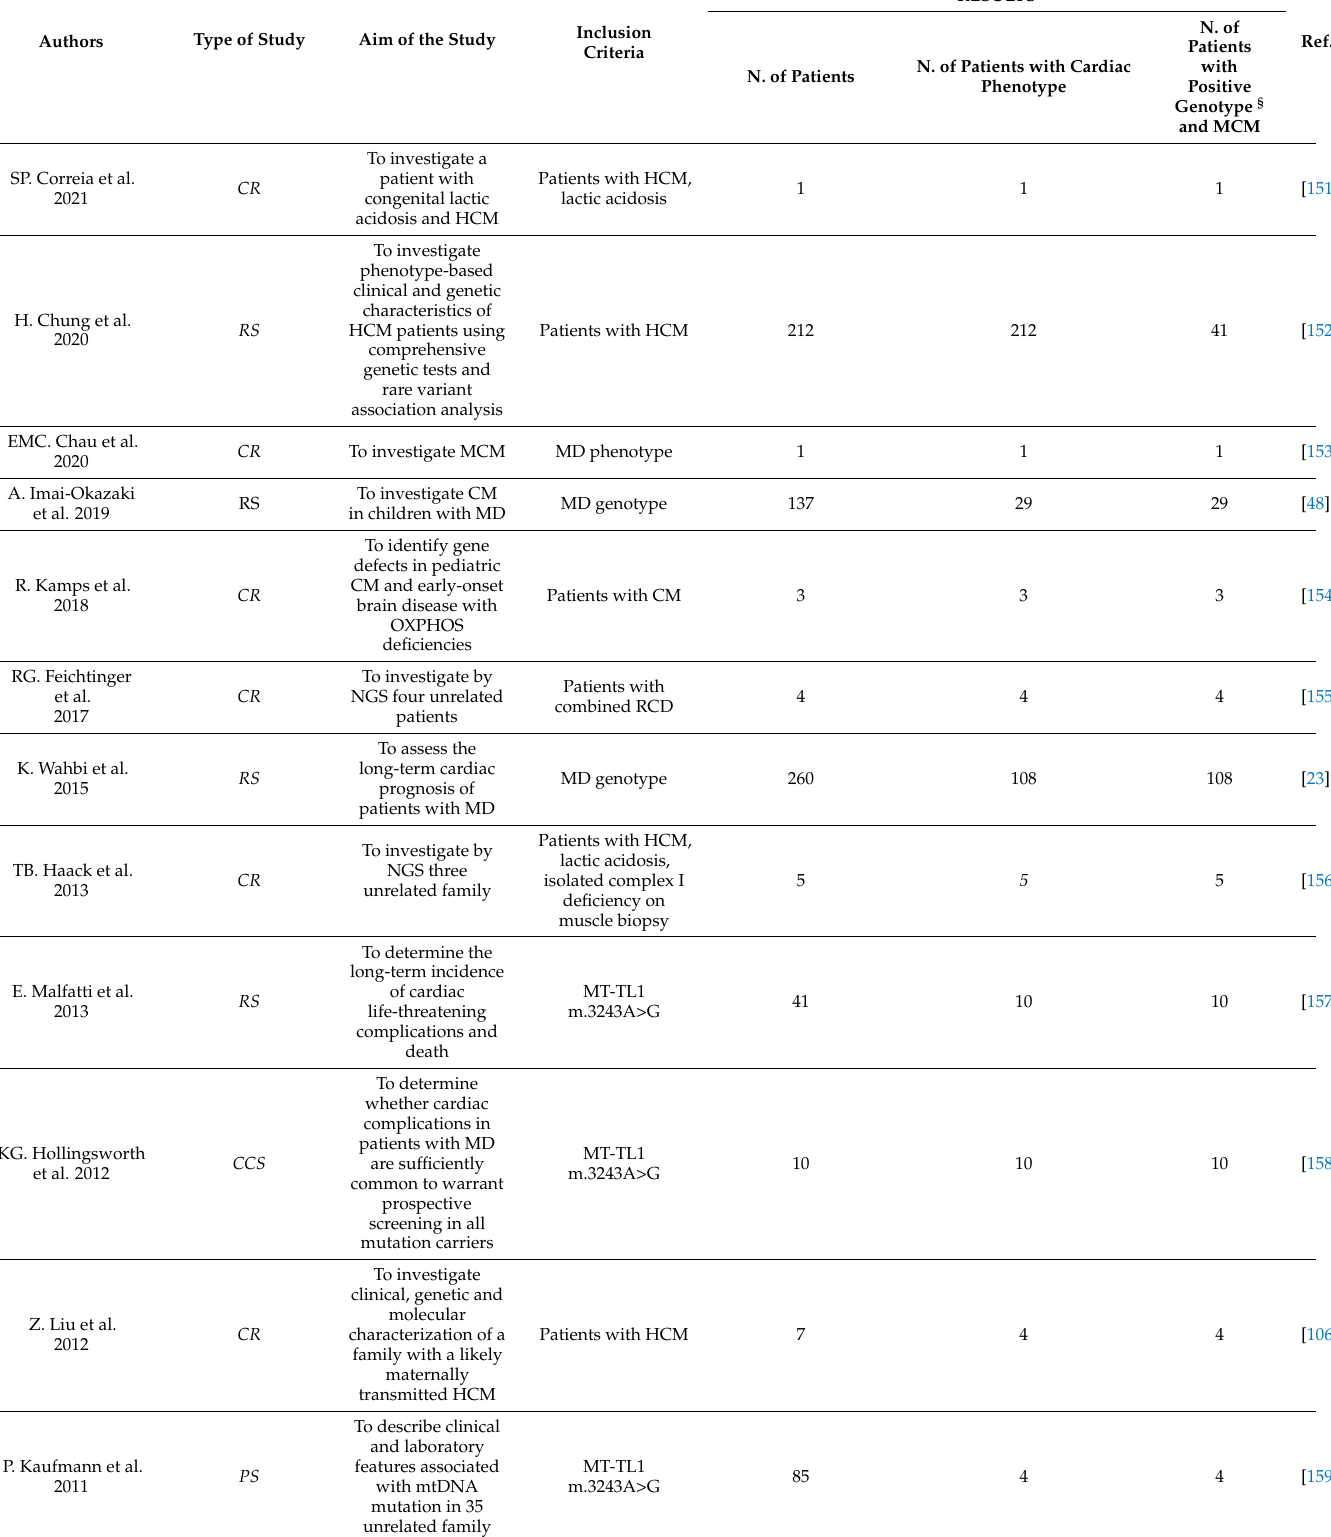
Table 2. Summary of literature data concerning the evaluation of cardiac manifestations in mitochondrial